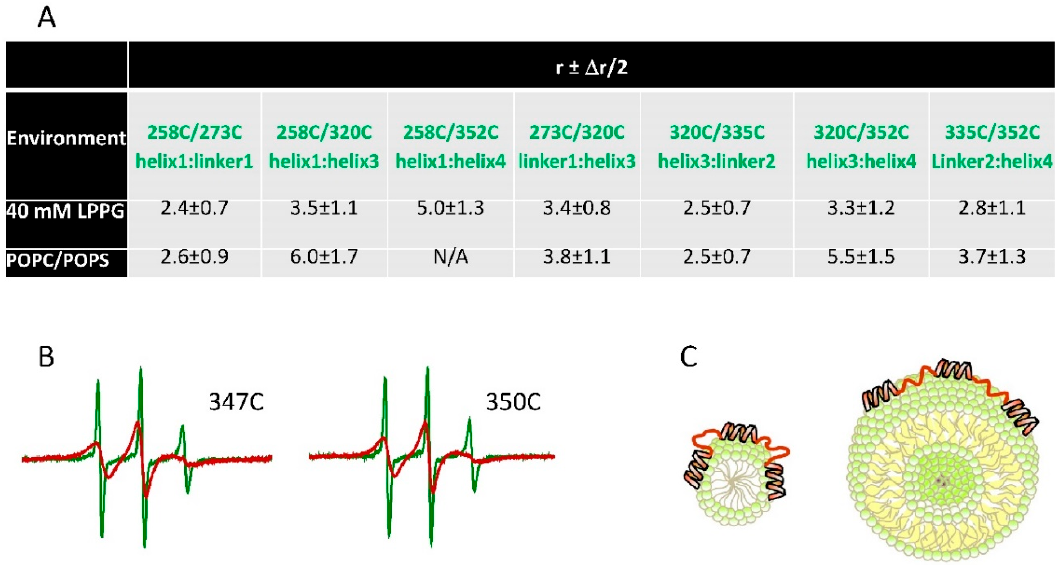
Figure 4. The structure of membrane-bound tau protein as revealed by EPR spectroscopy is shown [45]. ( A ) Long inter-spin distances were measured by DEER spectroscopy for spin-labeled residues located in microtubule binding domain (MBD) repeats. The spin-labeled residues and their locations are indicated in the second row of the table. The lipid membrane mimetic (environment) in which the distances were obtained is indicated in the first column. The obtained distances ( r ) suggest that tau MBD has distinct structures when bound to LPPG micelles and 1-palmitoyl − 2-oleoyl-glycero − 3-phosphocholine / 1-palmitoyl − 2-oleoyl-sn-glycero − 3-phospho-L-serine (POPC / POPS) liposomes. Longer distances in liposomes suggest more extended conformation. The distance distributions with relatively broad full widths at half maximum ∆ r indicated highly heterogeneous conformation of membrane-bound tau. ( B ) The binding of tau to lipid membranes was confirmed by CW EPR measurements. Nitroxide EPR lineshape broadening was observed for liposome-bound proteins (red spectra) compared to protein in solution (green spectra). The spin-labeled residues are indicated. ( C ) Model of tau-lipid membrane interaction based on the results from CW and DEER experiments was proposed—tau MBD structure when bound to micelles (left) and liposomes (right) is